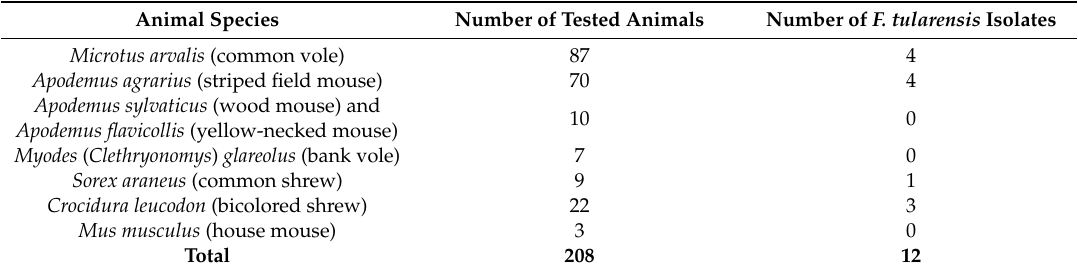
Table 3. Epizootic survey performed by Borˇci´c’s research group in 1974. Animals were collected at two locations in region of Middle Posavina, around town of Sisak. Animal Species Number of Tested Animals Number of F. tularensis Isolates Microtus arvalis (common vole) 87 4 Apodemus agrarius (striped field mouse) 70 4 Apodemus sylvaticus (wood mouse) and 10 0 Apodemus flavicollis (yellow-necked mouse) Myodes ( Clethryonomys ) glareolus (bank vole)